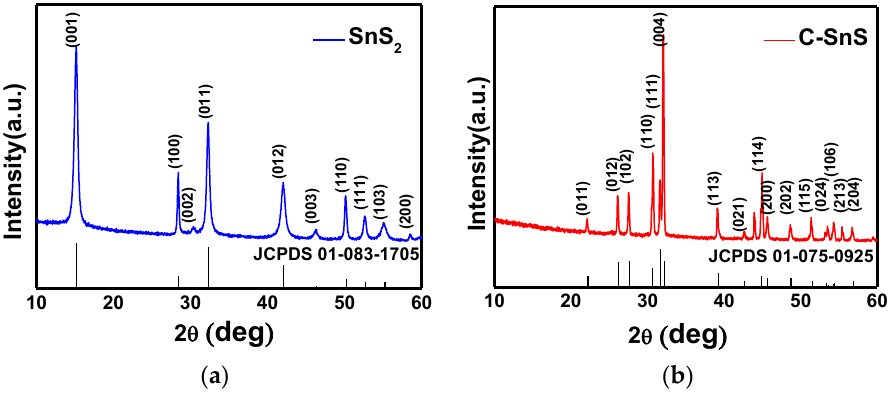
Figure 2. X-ray diffraction (XRD) θ/2θ scan of ( a ) SnS 2 and ( b ) carbon-coated SnS powders.